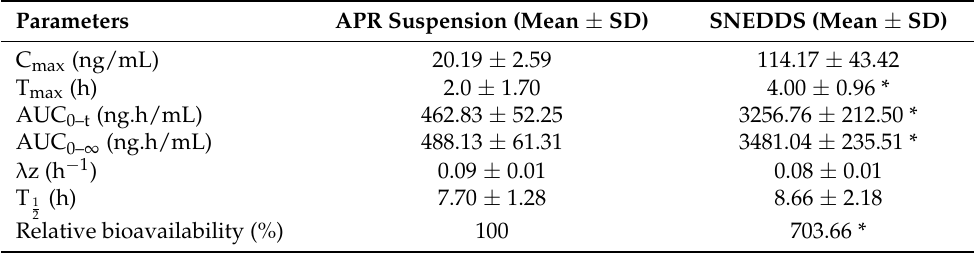
Table 6. Pharmacokinetic parameters of APR after an oral administration of optimized SNEDDS and APR suspension (3 mg / kg) in rats.